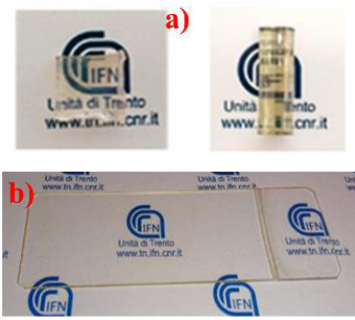
Fig. 1. Pictures of the densified SiO 2 -SnO 2 :Er 3+ transparent glass-ceramics in forms of a) monoliths [15] and b) planar